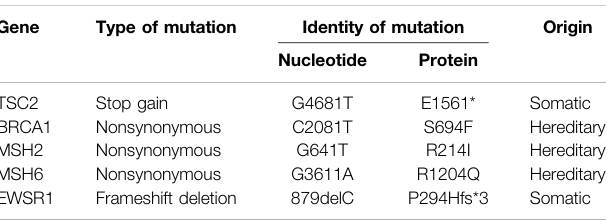
TABLE 2 | Gene mutations in